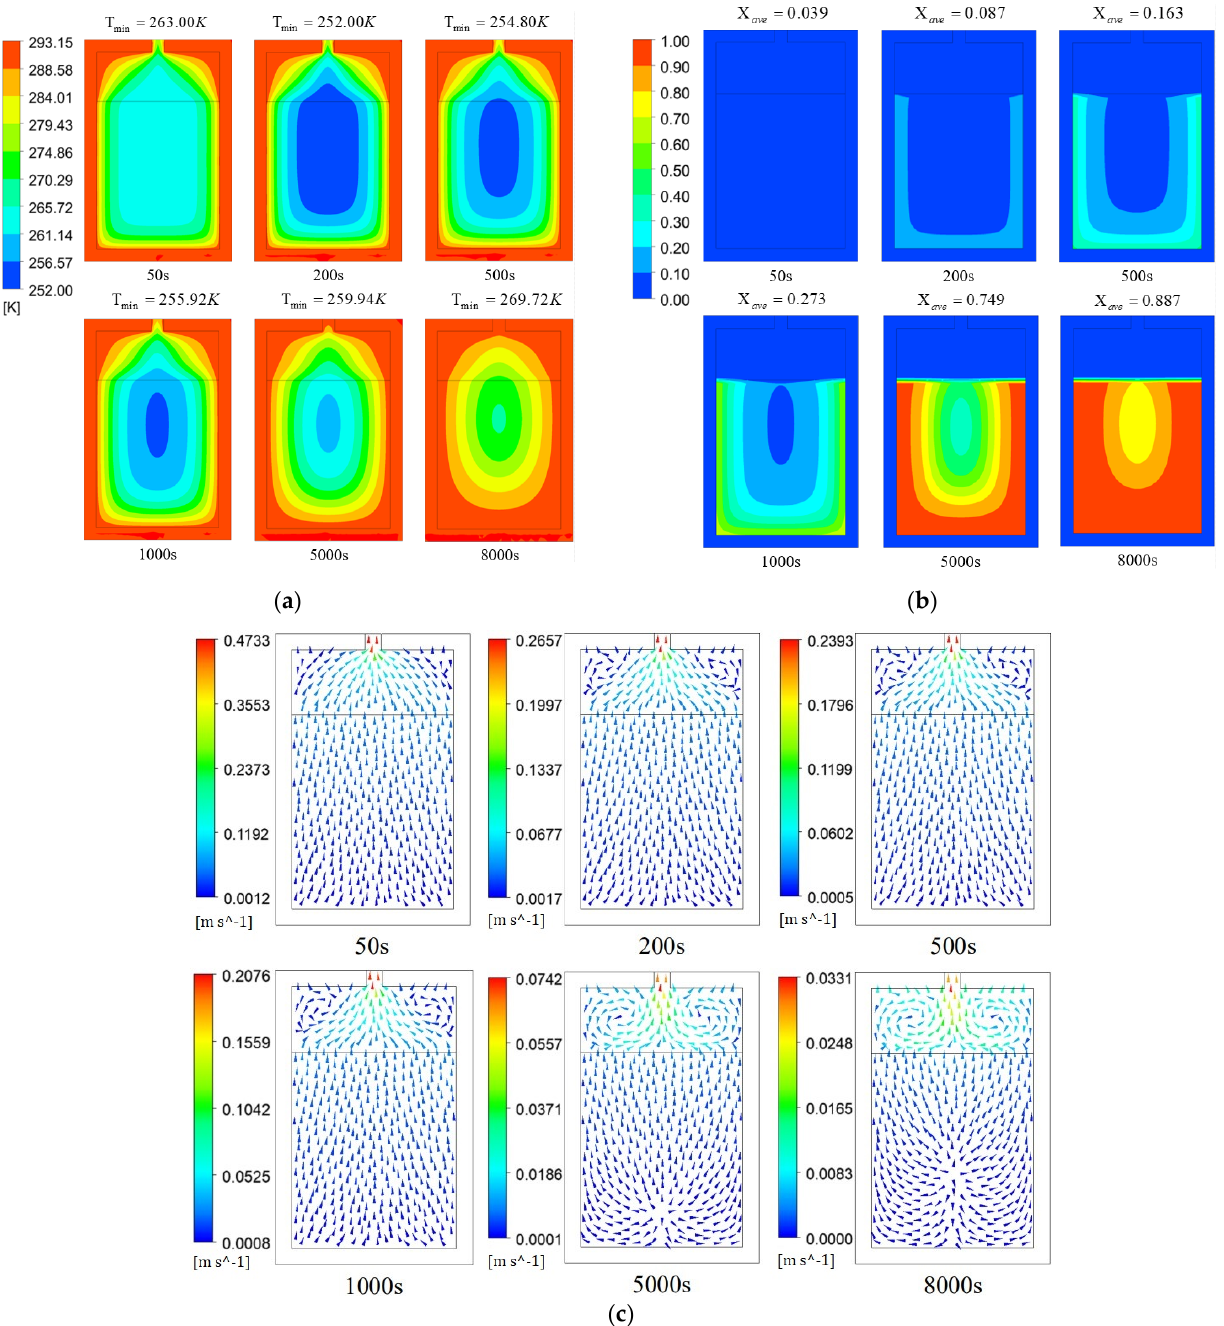
Figure 4. Temperature, reacted fraction and hydrogen flow velocity distribution in different times of the reaction tank subjected to a water at 293.15 K: ( a ) temperature distribution cloud figure; ( b ) reacted fraction distribution cloud figure; ( c ) velocity distribution cloud figure.